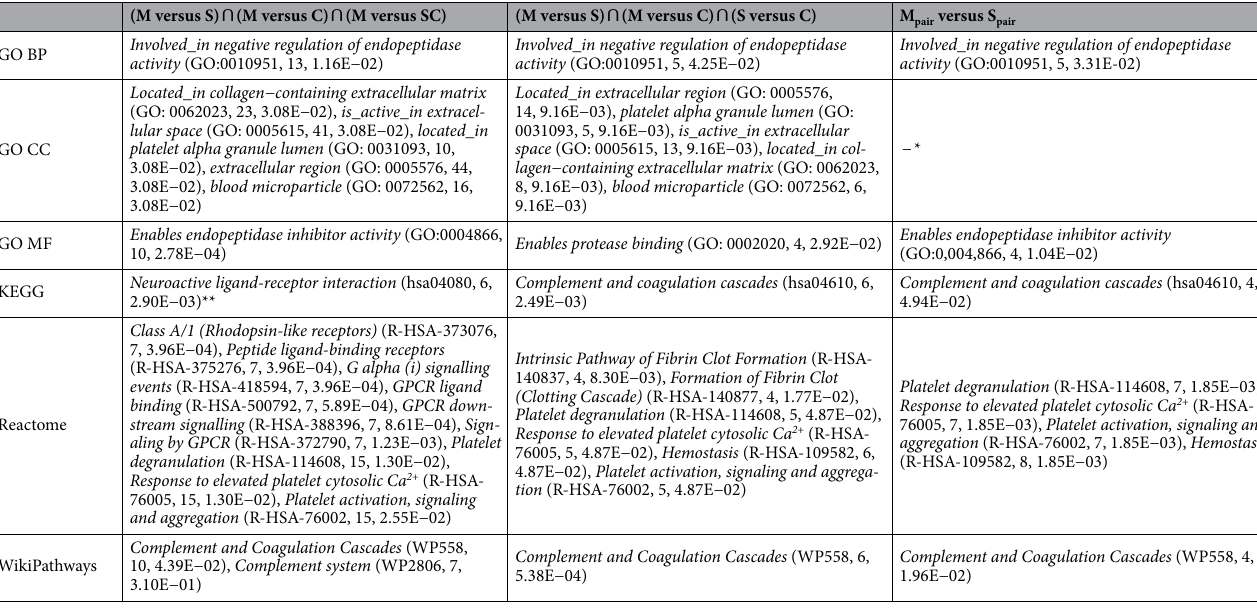
Table 6. Significant overrepresentation of gene ontology terms and pathway terms in selected sets of proteins. Significant overrepresentation of gene ontology terms and pathway terms in selected sets of proteins with a significant change in intensity. For other tested sets of proteins, see Supplementary file 7. GO term or pathway term identifier, number of detected proteins, and q value for overrepresentation test are listed in parentheses. GO—Gene Ontology terms, BP—biological processes, CC—cellular component, MF—molecular function. *Terms with the lowest q values are located_in platelet alpha granule lumen (GO: 0031093, 4) and located_in extracellular region (GO: 0005576, 12), yet their q values (both 7.40E−02) are above the 0.05 limit. ** Complement and coagulation cascades term here is the third one according to Fisher’s exact test p values,